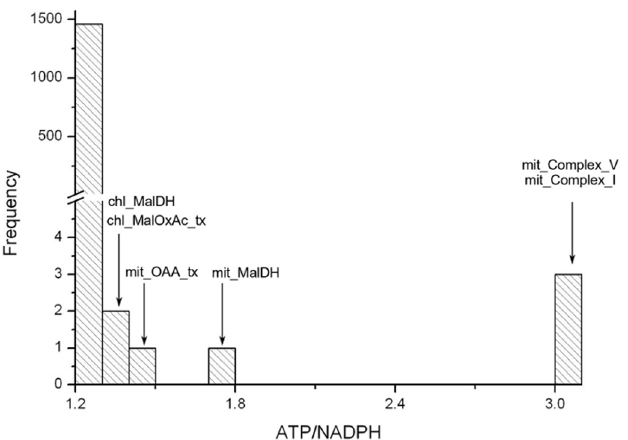
Fig 6. Variation of ATP/NADPH ratio due to deletions of reactions. ATP and NADPH produced in the light reactions are calculated by the their stoichiometric coefficient times the flux of the light reactions. Deletions of a few mitochondrial and chloroplastic reactions (shown by down arrow) increase the ATP/NADPH